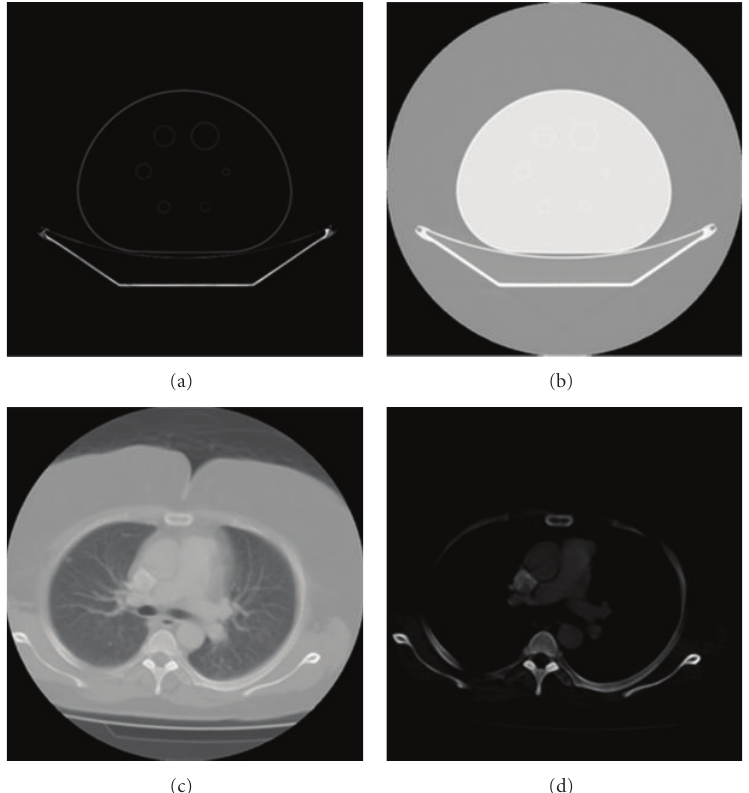
Figure 14: Curvelet transform for segmentation. (a) NEMA IEC body phantom, (b) segmented phantom slice, (c) original real chest slice, and (d) segmented real chest slice.